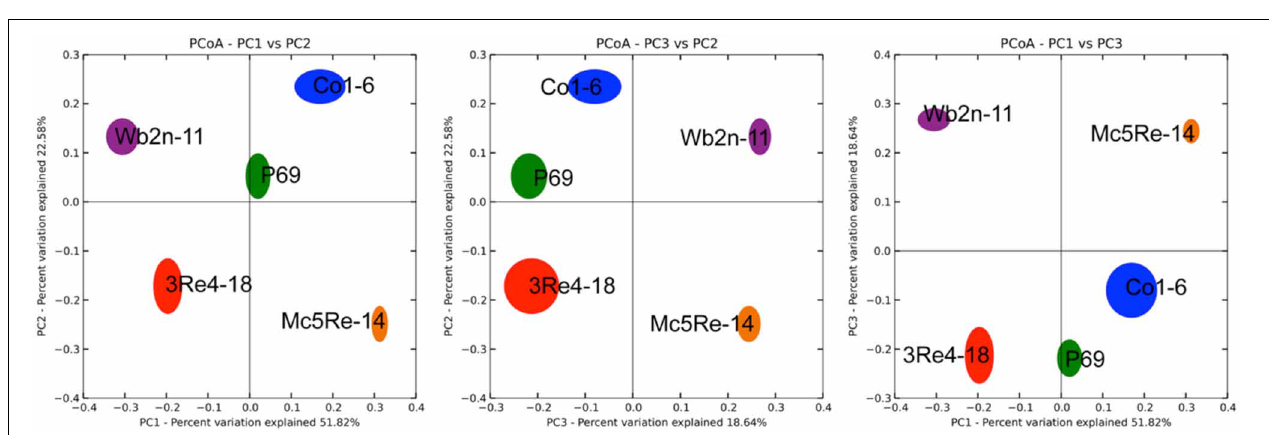
with an 80% confidence threshold. Taxa below 1% of relative abundance are included in “Other.” Multi-colored charts at the legend are shown for each sample correspondingly.